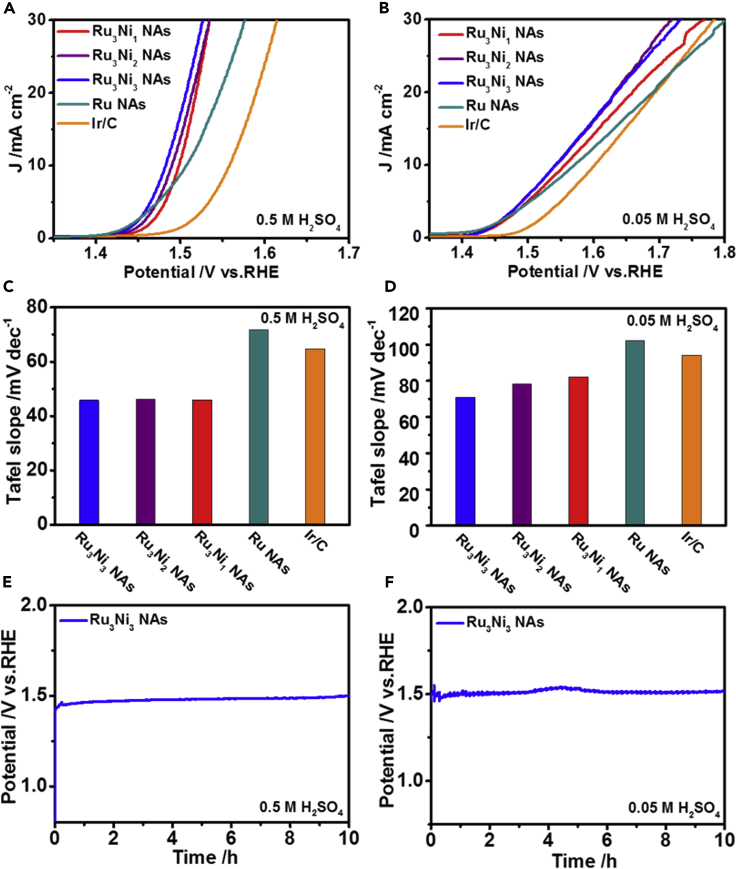
OER Performances of the Ru3Ni3 NAs, Ru3Ni2 NAs, Ru3Ni1 NAs, Ru NAs, and Commercial Ir/C under Different Acidic Conditions(A and C) (A) The polarization curves and (C) corresponding Tafel plots in 0.5 M H2SO4.(B and D–F) (B) The polarization curves and (D) corresponding Tafel plots in 0.05 M H2SO4. Scan rate is 5 mV s−1. Chronopotentiometry curves of the Ru3Ni3 NAs in (E) 0.5 M H2SO4 and (F) 0.05 M H2SO4 solutions at a current density of 5 mA cm−2.